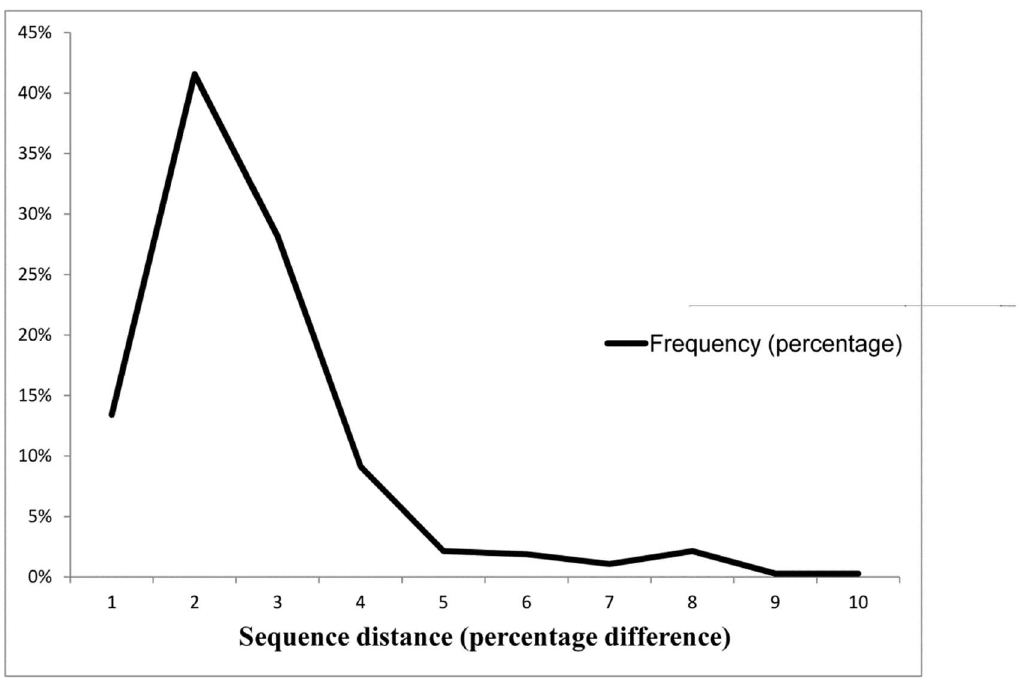
Figure 2. The distribution of uncorrected genetic distance between the sequences from the same patient. The median genetic distance between sequences from the same patient was 1.5% (95% range: 0.1% to 7.5%).